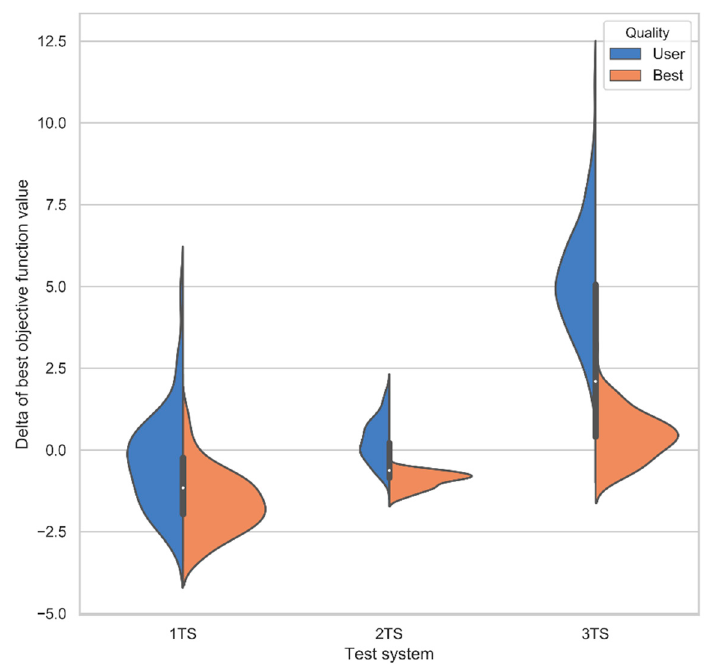
Figure 11. Violin plots for the resultant objective function value deviations from the initial points for the test cases under consideration calculated using the di ff erential evolution method with user-defined (first test system (1TS), second test system (2TS), and third test system (3TS): s = 50, F = 0.5) and optimal (1TS: s = 93, F = 0.42; 2TS: s = 80, F = 0.30; 3TS: s = 90, F = 0.21) parameters.